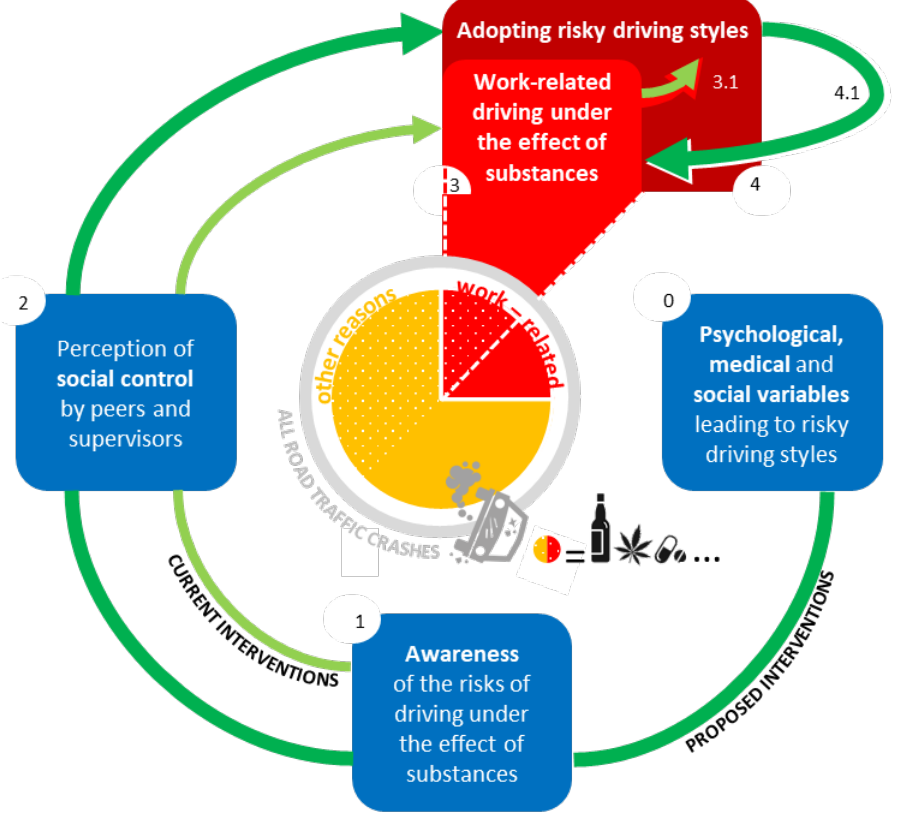
Figure 2. A model of